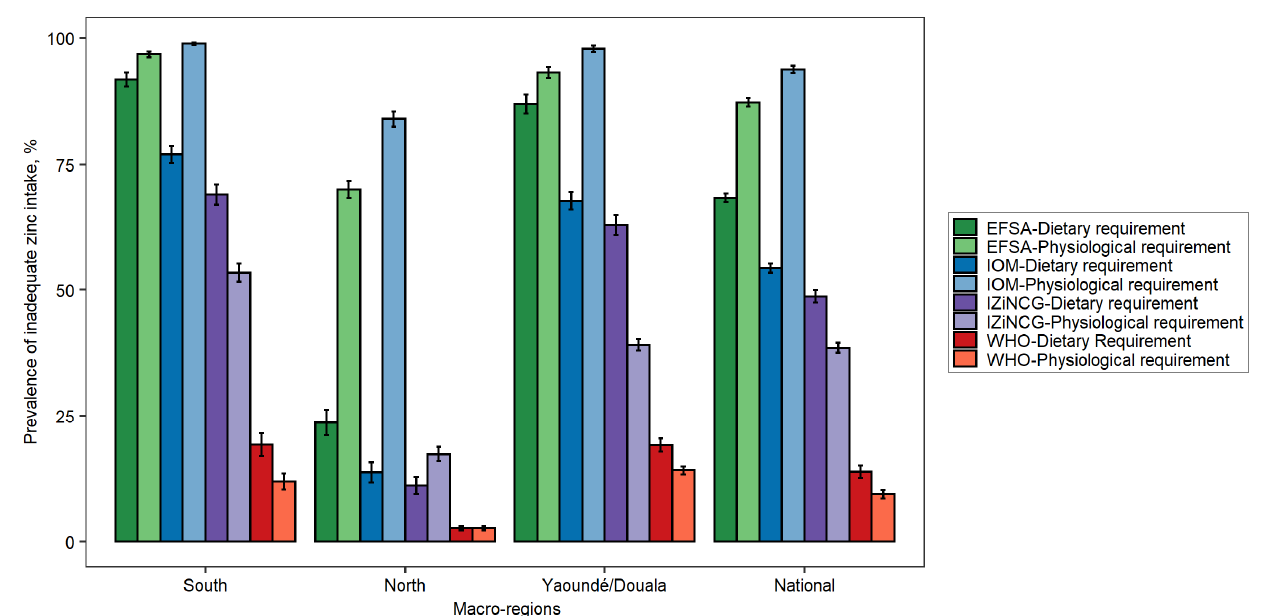
Figure 4. Estimated prevalence of inadequate zinc intake among women of reproductive age in Cameroon according to different NRVs. Error bars indicate standard errors. EFSA, European Food Safety Authority; IOM, US Institute of Medicine; IZiNCG, International Zinc Nutrition Consultative Group; WHO, World Health Organization